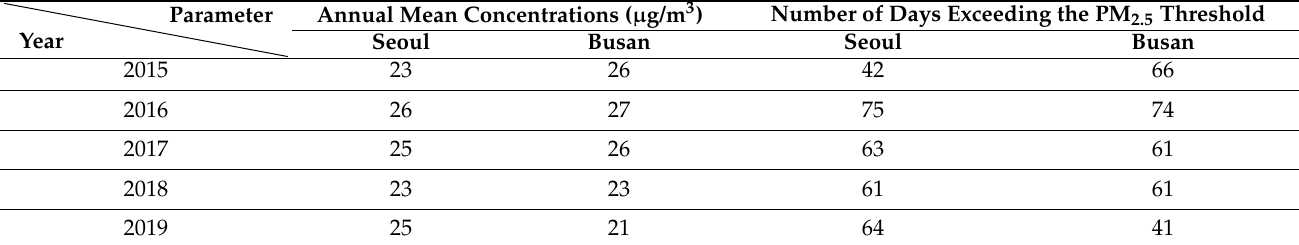
Table 1. Annual mean concentrations and the number of days exceeding 35 μ g/m 3 of PM 2.5 in Seoul and Busan.